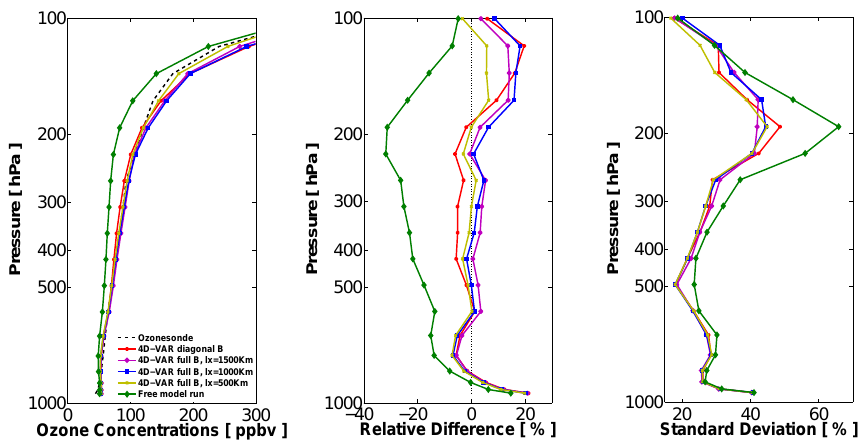
Fig. 6. The impact of non-diagonal background error covariances on 4D-Var data assimilation. The results shown are for a single 5-day assimilation window from 00:00GMT on 1 August to 00:00GMT on 6 August 2006. Left panel: mean ozone concentrations at ozonesonde locations for 4D-Var analyses and free model trajectories. Center panel: relative mean errors of predicted ozone concentrations with respect to ozonesonde measurements. Right panel: standard deviation of absolute values of errors with respect to ozonesonde